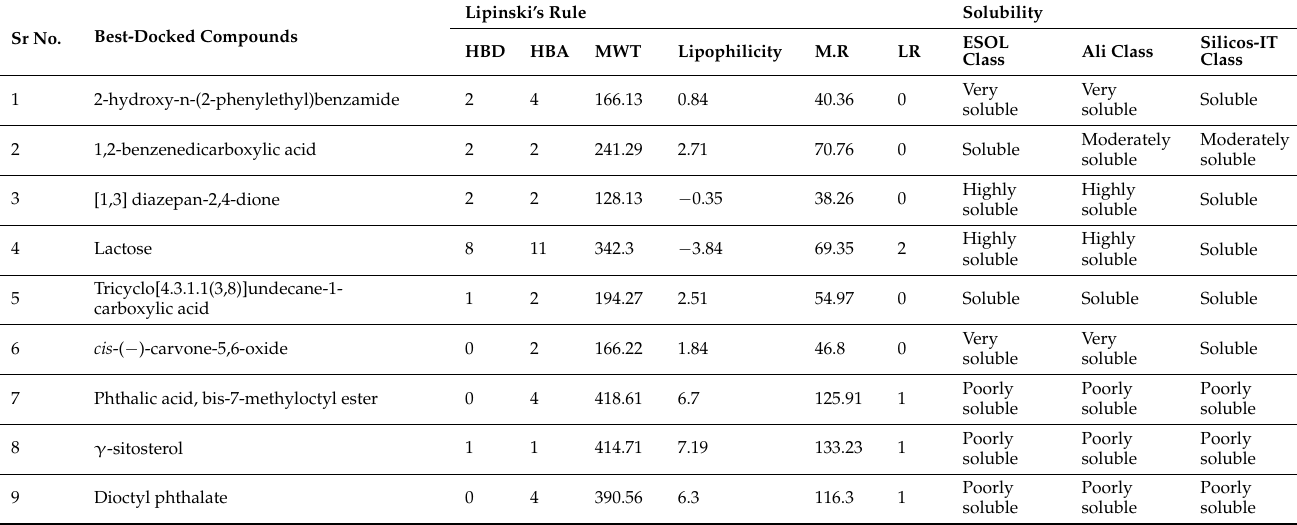
Table 9. Solubility and Lipinski’s rule criteria of the